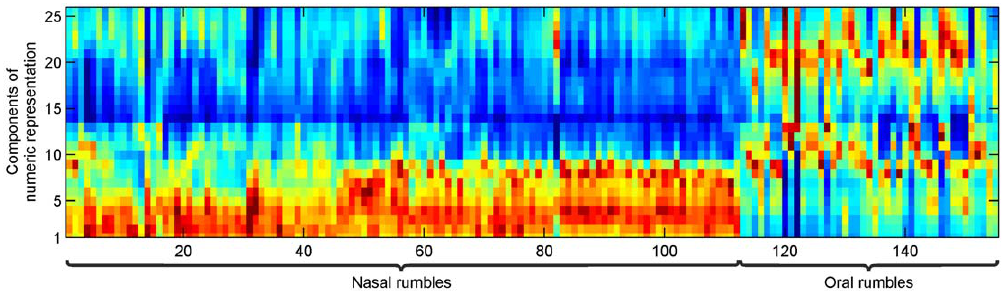
Figure 4. Automatic classification of rumbling vocalizations. Numerical descriptors (averaged LPC spectrum) for all sound samples in the experiments. Each column of the matrix represents one descriptor of a rumble. Red represents spectral peaks while blue represents low spectral components. The descriptors of the nasal and oral rumbles show significantly different characteristics.